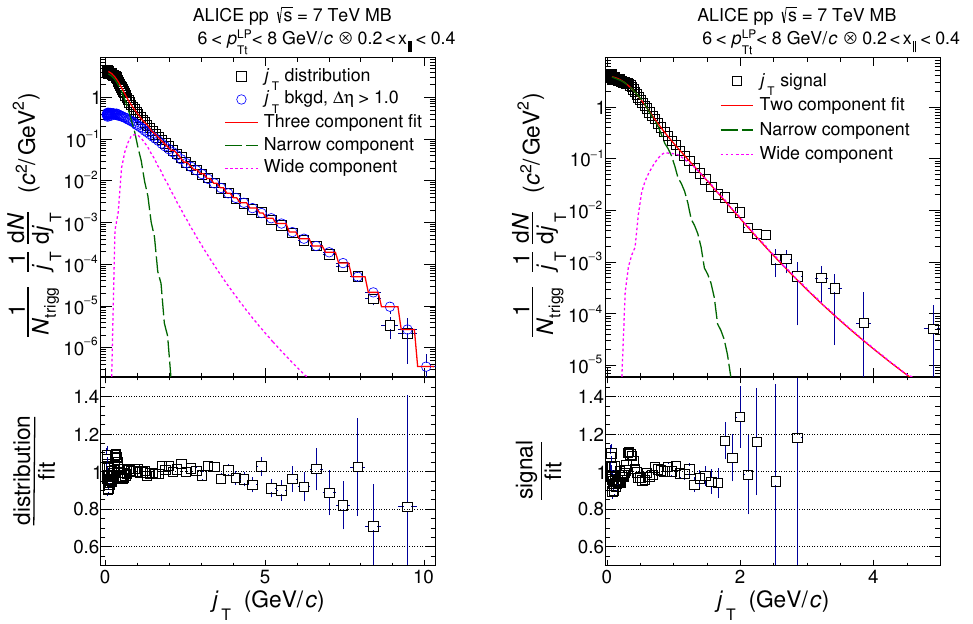
Figure 3 . Left : measured j T distribution including a three-component (cid:12)t. The three components describe the background (circular symbols), hadronization (long dashed line), and showering (short dashed line). Right : the same j T distribution but with background